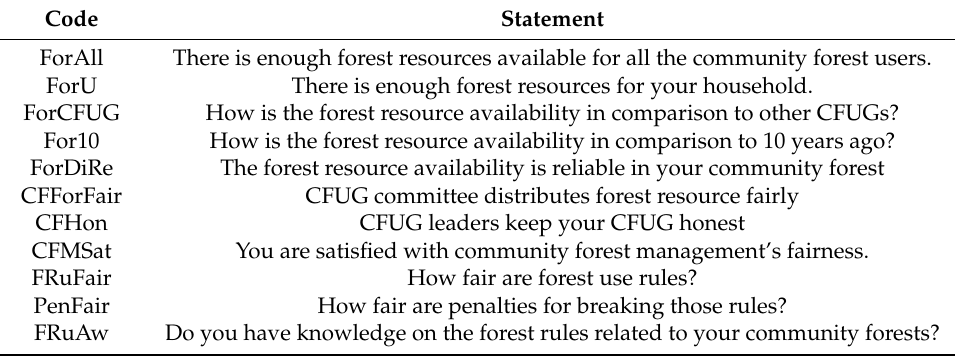
Table 2. Coding and statements/questions related to perception items in the household survey.